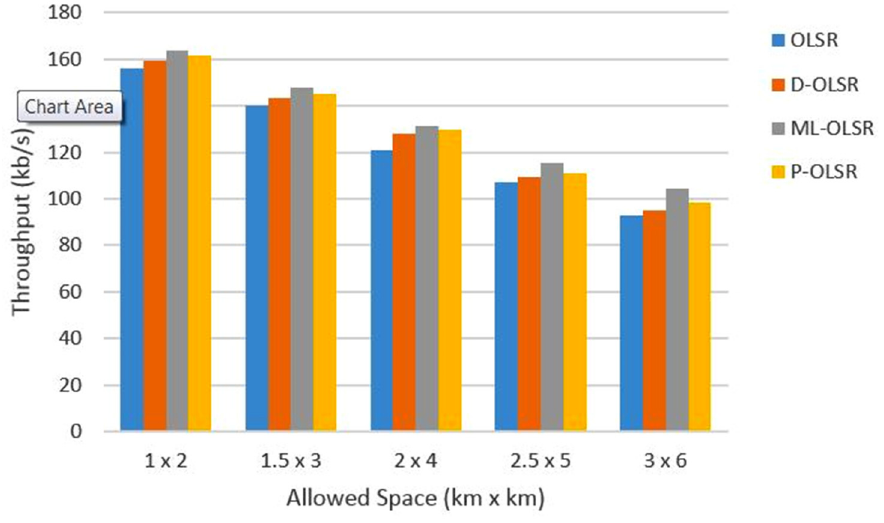
Figure 17. Throughput vs. allowed space. Table 5. Summary of the OLSR-based routing protocols based on the three simulation scenarios and performance